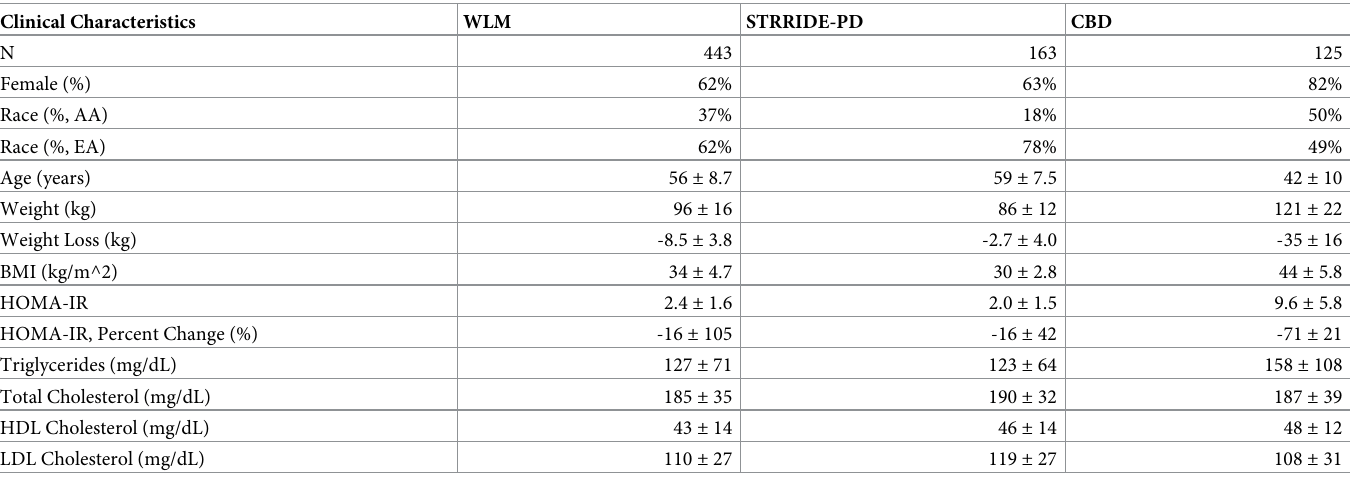
Table 1. Baseline characteristics of the study populations. Clinical